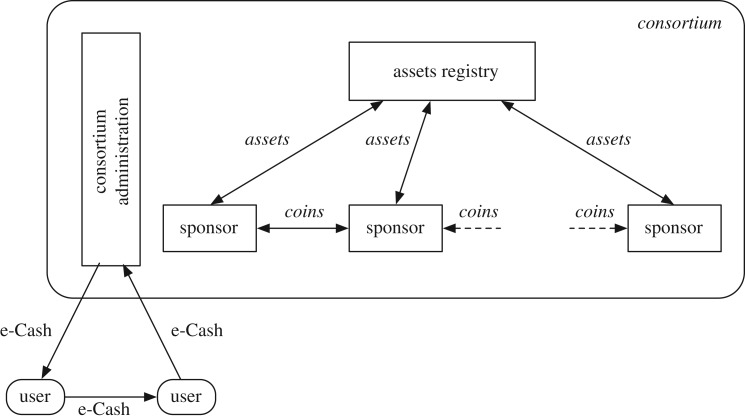
Tradecoin entities.